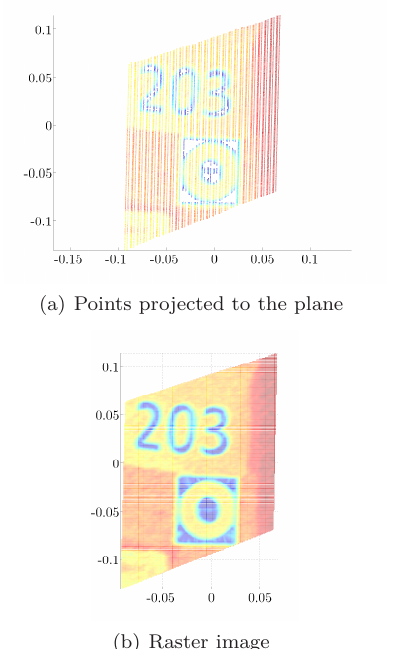
Figure 3: Points projected on to the reference plane